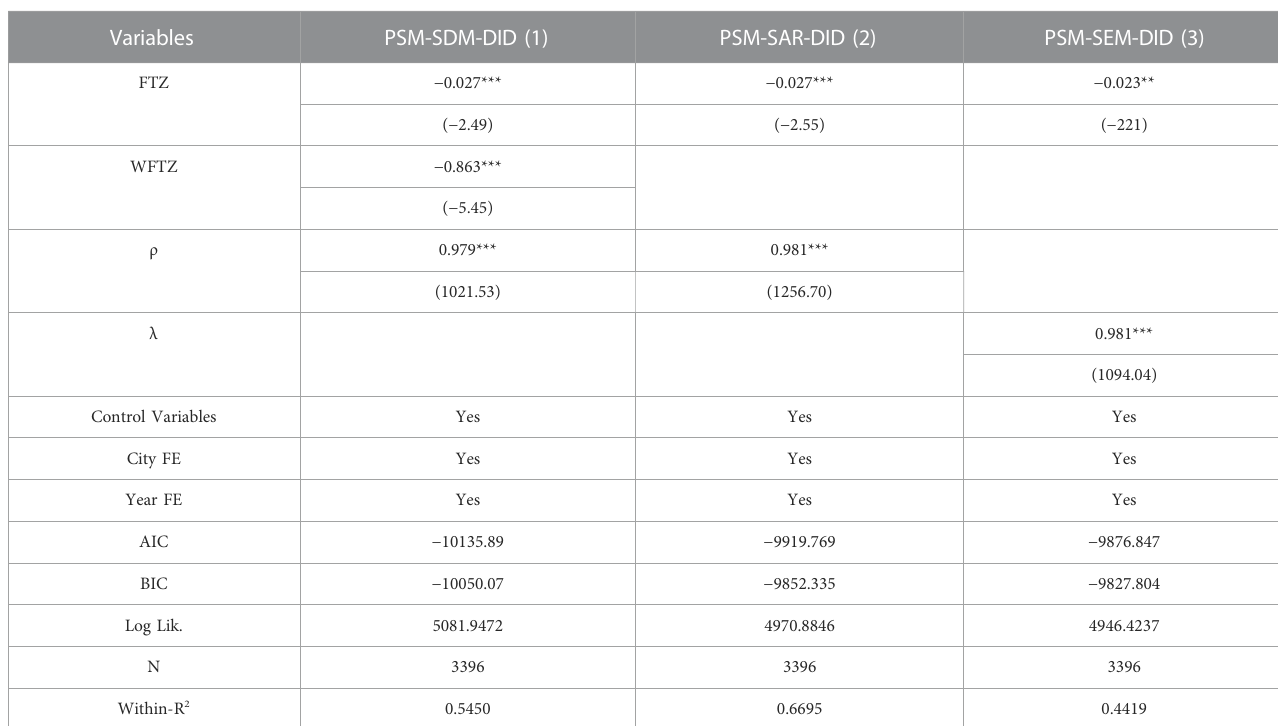
TABLE 8 Results of